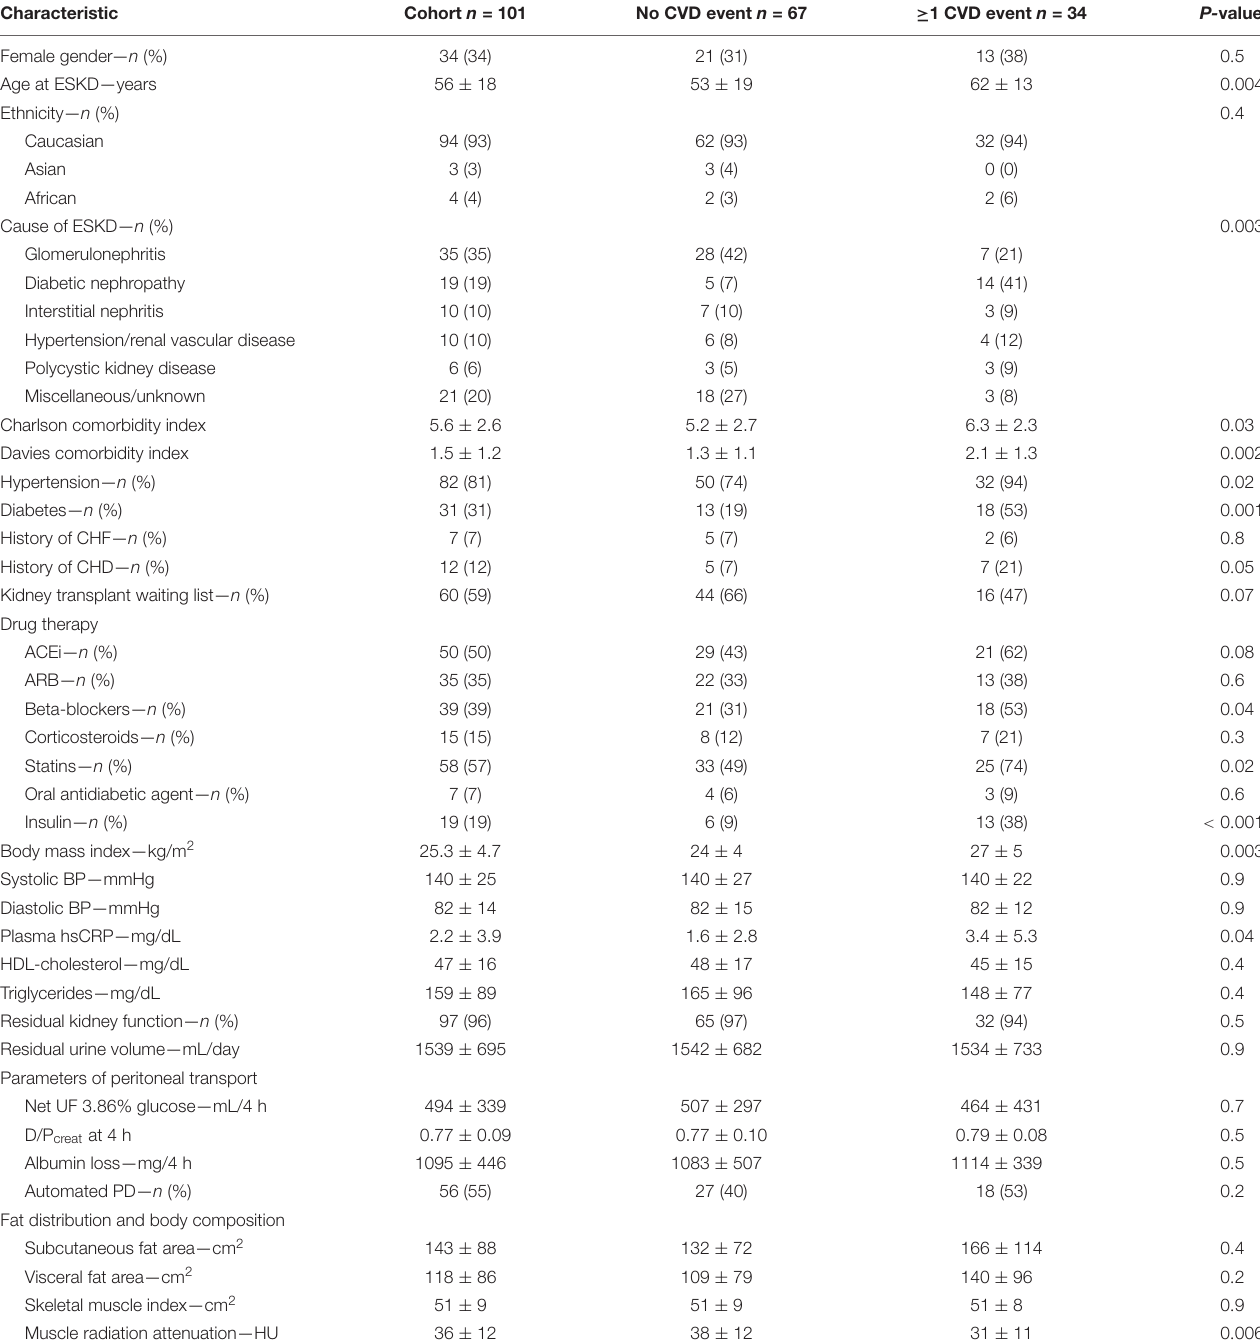
TABLE 1 | Baseline